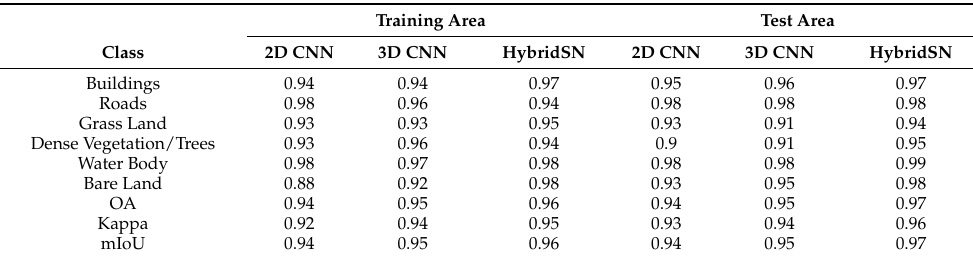
Table 4. Classification assessment of different CNN methods used with the proposed model for the training and test areas.